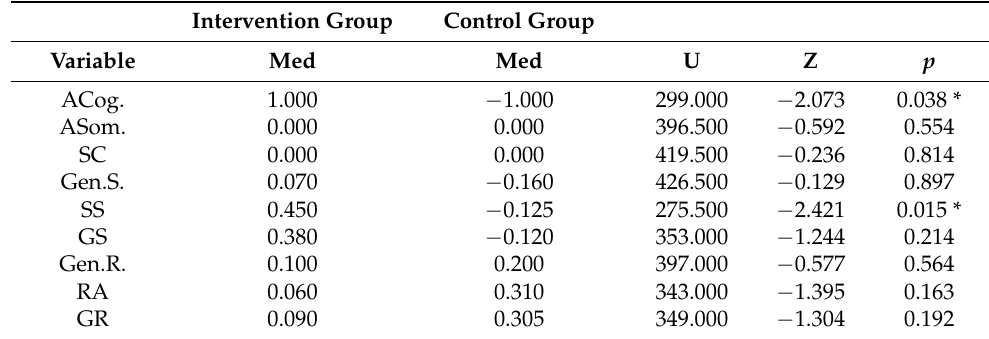
Table 3. Mean pre- and post-intervention differences of the three subscales of state anxiety (CSAI-2) and the six subscales of stress and recovery (RESTQ-Sport) for athletes in the intervention and control groups, and p -value resulting from the comparison performed with the Mann–Whitney